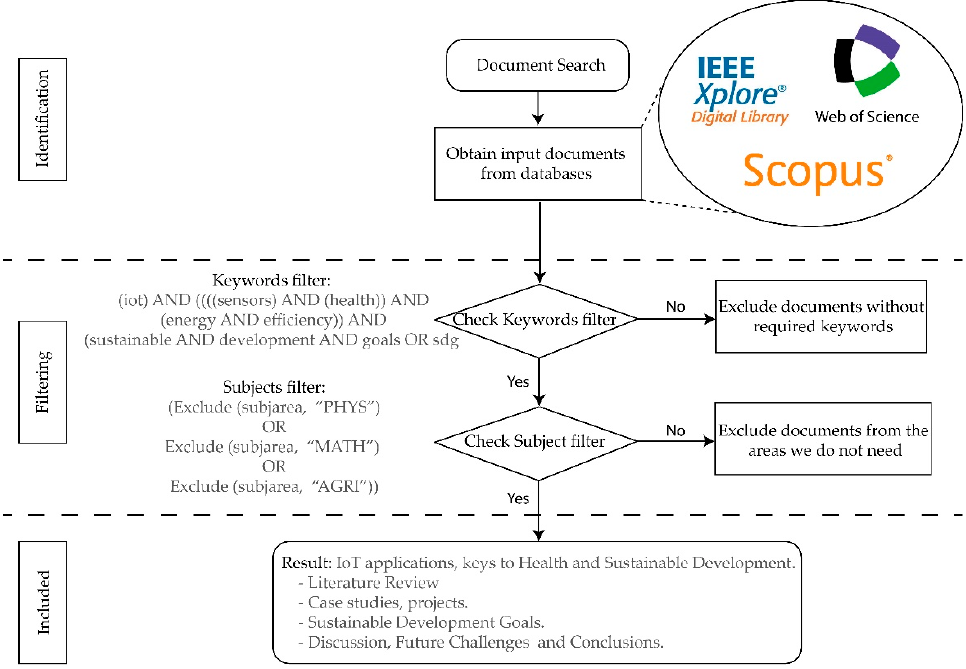
Figure 3. Structure of the methodology.